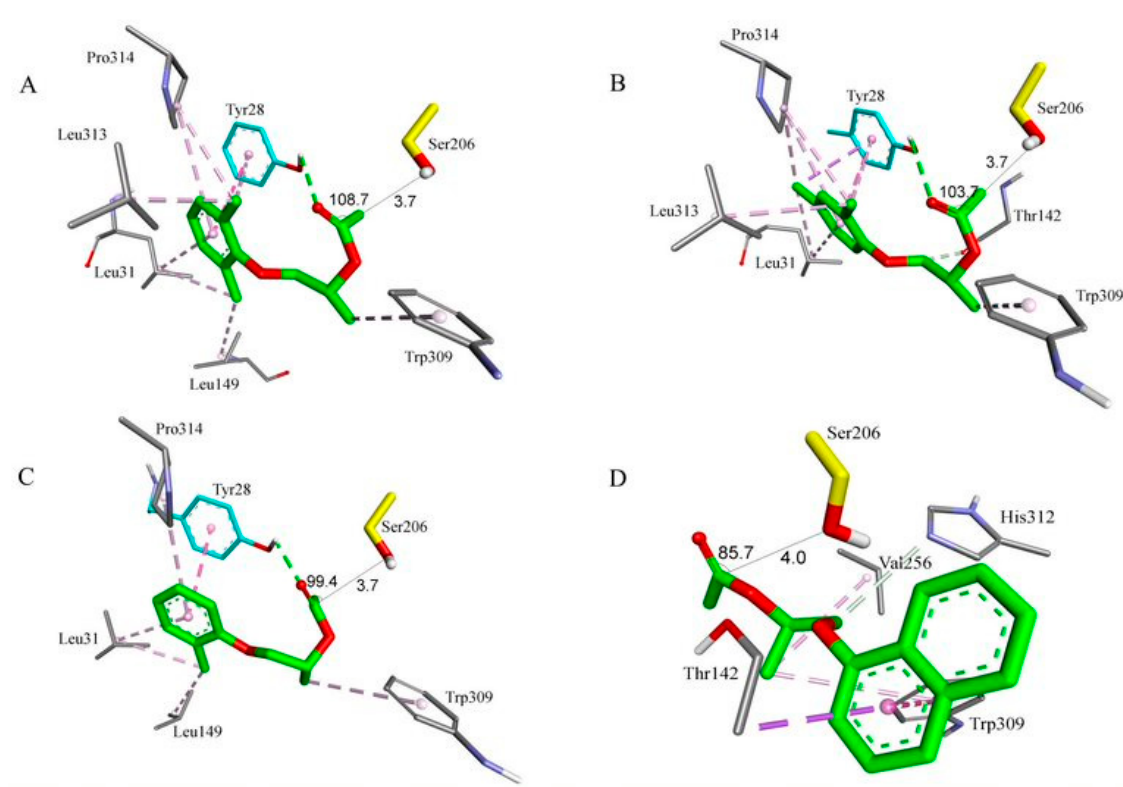
Figure 4. Interactions between P. fluorescens lipase and substrate ( R )- 5a - d that follow the criteria established by the NAC. P. fluorescens and substrate ( R )-5a (subfigure A); P. fluorescens and substrate ( R )-5b (subfigure B); P. fluorescens and substrate ( R )-5c (subfigure C) and P. fluorescens and substrate ( R )-5d (subfigure D). Green dotted lines indicate hydrogen bonds with the oxyanion